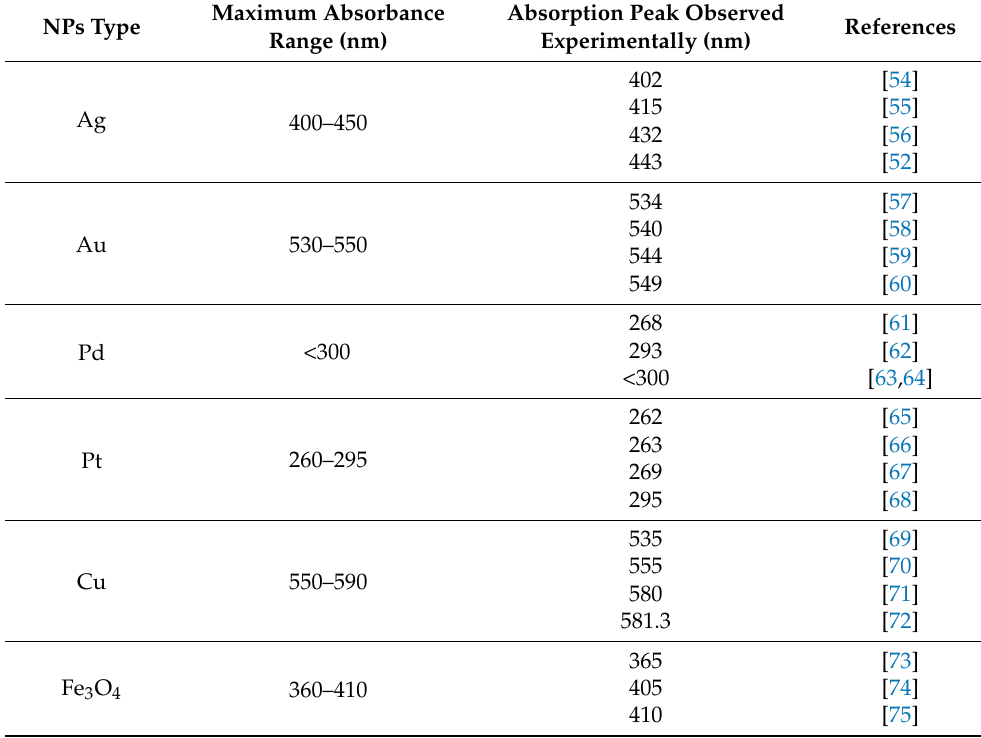
Table 1. The maximum absorption peak of different NPs synthesized via green